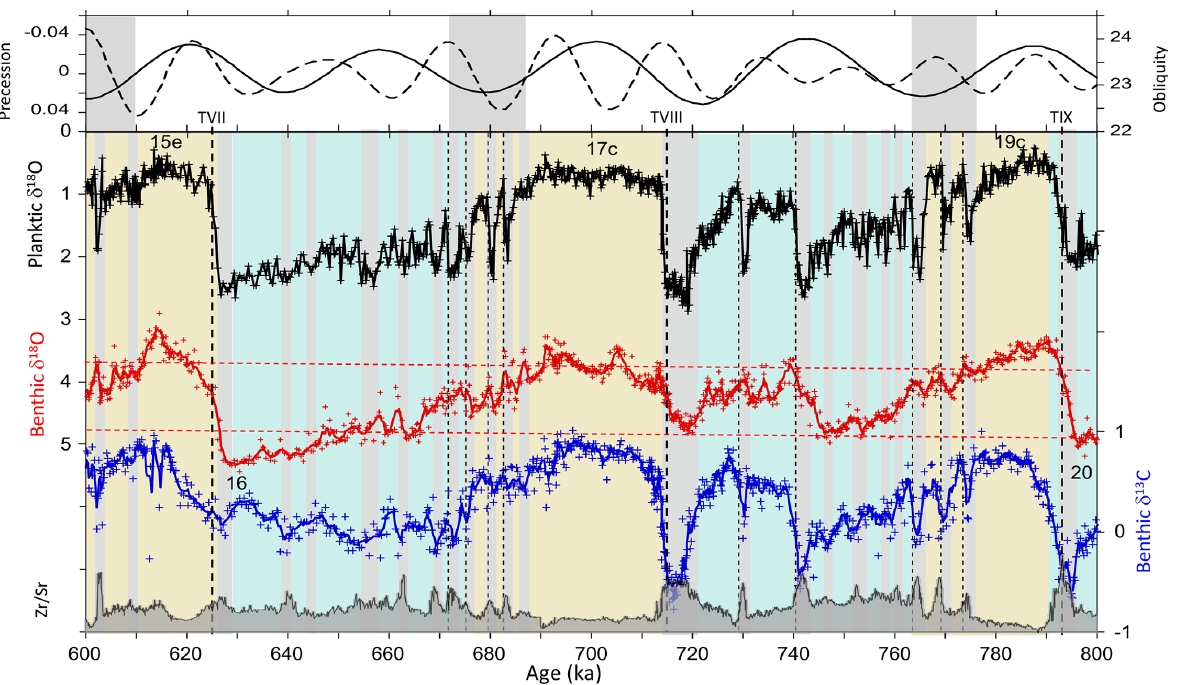
Figure 9. Same as Fig. 6 but for 600–800ka. Note the progressive decrease in the amplitude of millennial events from MIS 17C to the peak of MIS 16 and from MIS 19c to 18.